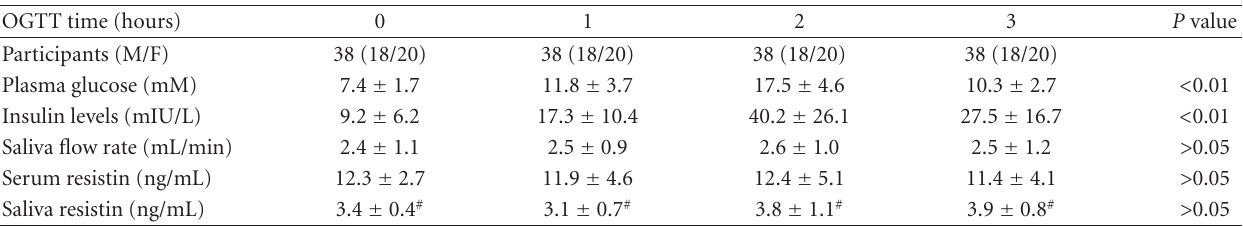
Table 2: The general information and laboratory data of the new diagnosed diabetic patients at each time point of OGTT. OGTT time (hours)